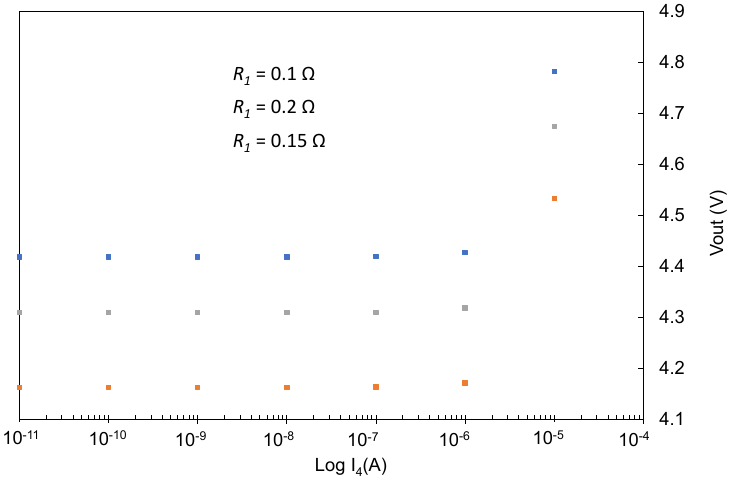
Figure 7. Output RMS voltage obtained in a current source load situation ( I 4 ) for different damping coefficients ( R 1 ) and high coupled system.